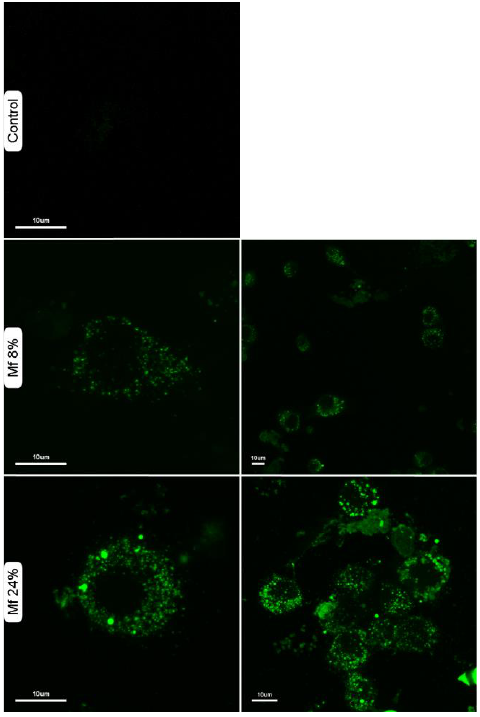
Figure 11. Confocal laser scanning microscopy imaging of murine macrophages in different conditions: untreated (control), after incubation with Mf 8% or Mf 24% . Macrophages were suspended in a solution of fluorescent mannan (1 mg/mL) for 30 min at 37 °C, then washed three times with buffer.